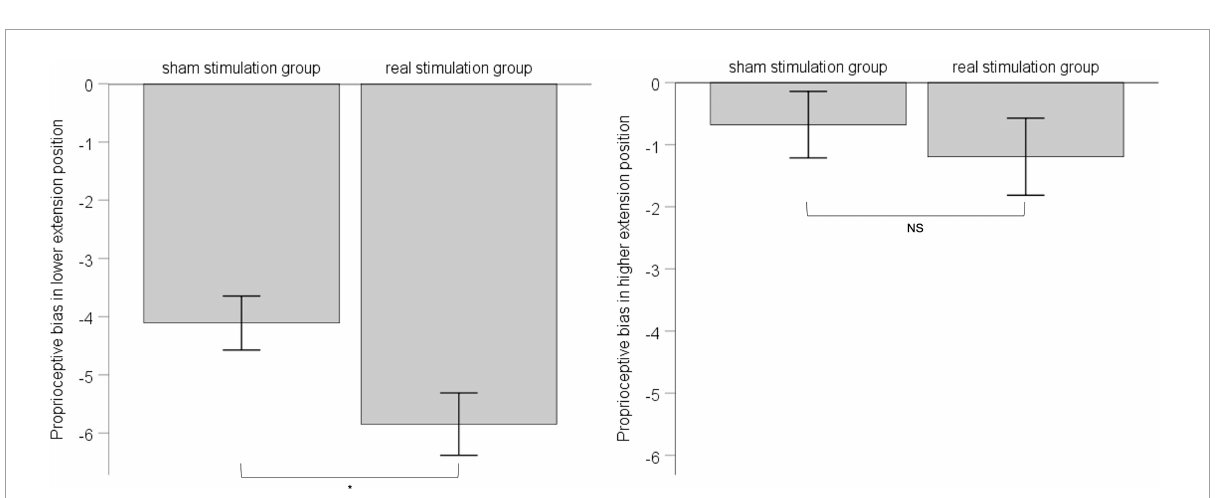
FIGURE4 The left panel shows post-stimulation performance of proprioceptive bias in the lower-extension position; the right panel shows post-stimulation performance of proprioceptive bias in the higher-extension position. Error bars indicate Standard Error. * indicates p < 0.05. NS indicates no statistical